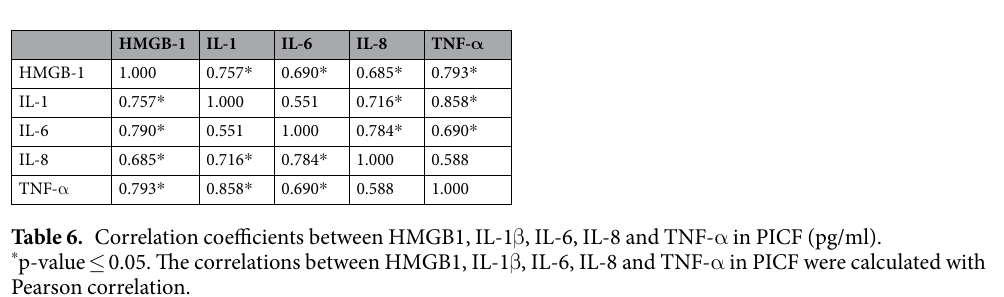
Table 5. Comparison of the concentrations of HMGB1 in different mPI groups. The differences in the concentration of HMGB1 in the different groups were compared with a one-way ANOVA.